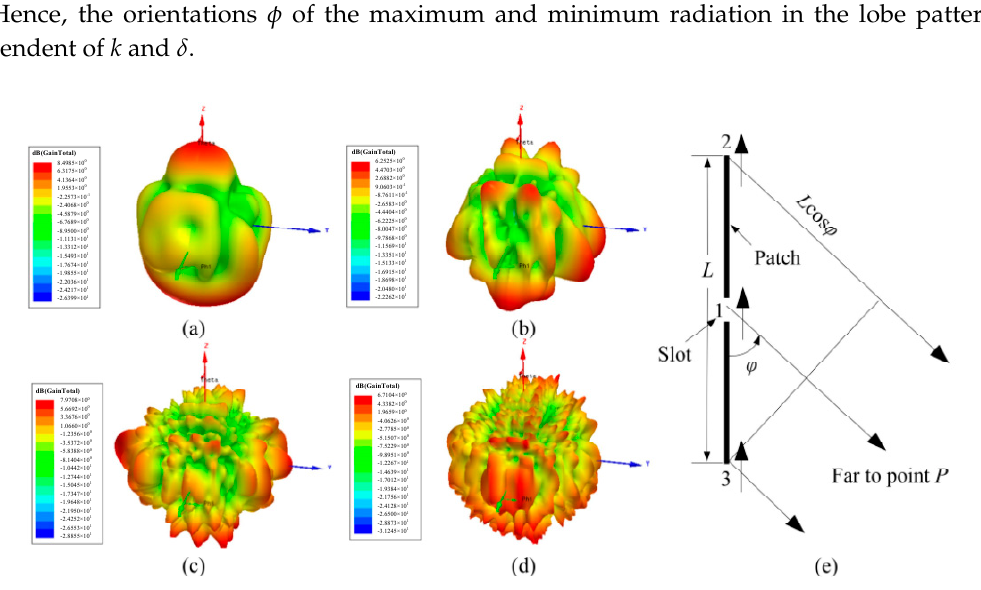
Figure 3. The simulated 3D gain total of the slot patch with a slot width of 2 mm and a length of 32 mm, where L = ( a ) 40 mm, ( b ) 100 mm, ( c ) 200 mm, and ( d ) 300 mm, respectively. ( e ) The cross-sectional view of the finite length patch.